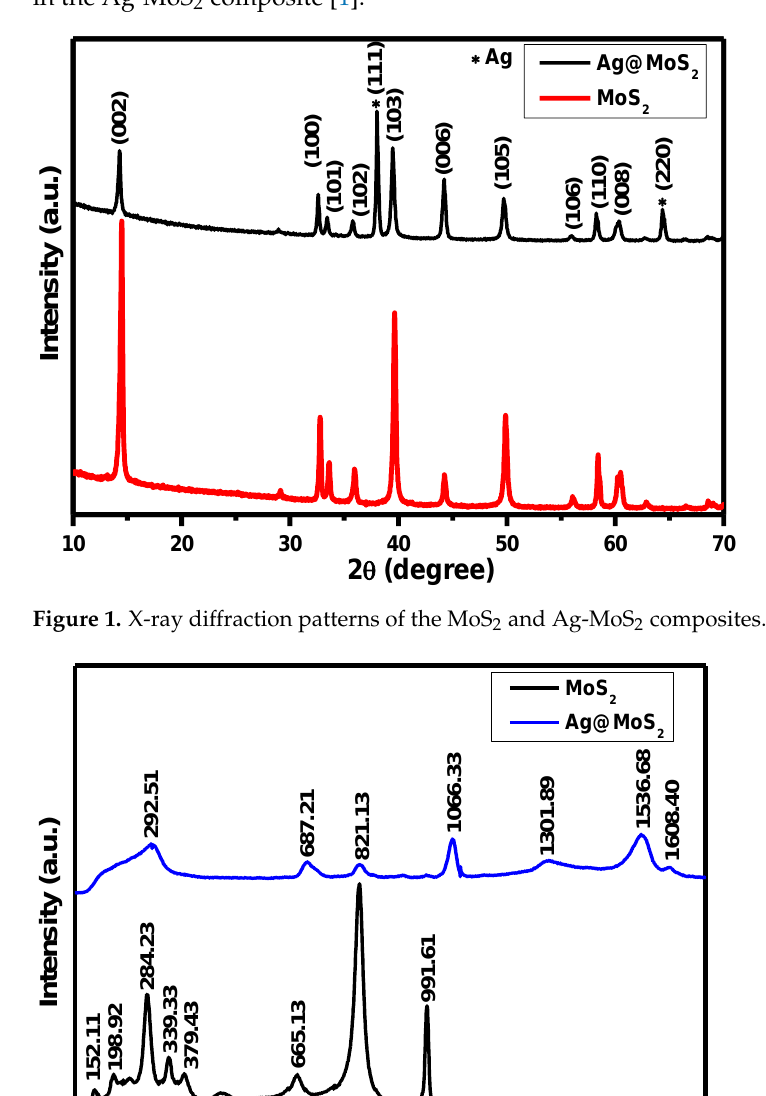
529.89 and 532.32 eV (Figure S1c). The peaks at 529.89 and 532.32 eV correspond to lattice oxygen and OH − groups, respectively [3]. Figure 3 presents the XPS study of the Ag-MoS 2 composite. Figure 3a presents the survey scan spectrum of the Ag-MoS 2 composite. It confirms the occurrence of Ag 3d, Mo 3d, S2p, and O 1s elements. No other impurity elements were detected. Figure 3b presents the Ag 3d spectrum, which splits into two major peaks having binding energy 373.56 and 367.51 eV, which confirm Ag 3 d3/2 and Ag 3d 5/2, respectively [25]. Figure 3c displays the high-resolution Mo 3 d spectrum. The Mo A g @ M o S 2 3d spectrum splits into Mo 3d 5/2 and Mo 3d 3/2 with binding energies (BEs) of 229.02 and 232.21 eV, respectively [26]. The S2p spectrum is shown in Figure 3d. The S2p spectrum splits into two major peaks, having BE at 161.90 and 163.02 eV, which are associated with the S 2p 3/2, and S 2p1/2, respectively [27]. The O 1s spectrum is shown in Figure 3e, . ) u and it is split into two major peaks with binding energies of 532.23 eV (O1) and 533.78 eV (O2), which correspond to the core level O 2 , and S-O bonds, respectively [1,11]. Not much difference was observed in the binding energy of MoS 2 , as compared to the MoS 2 presented in the Ag-MoS 2 composite [1].